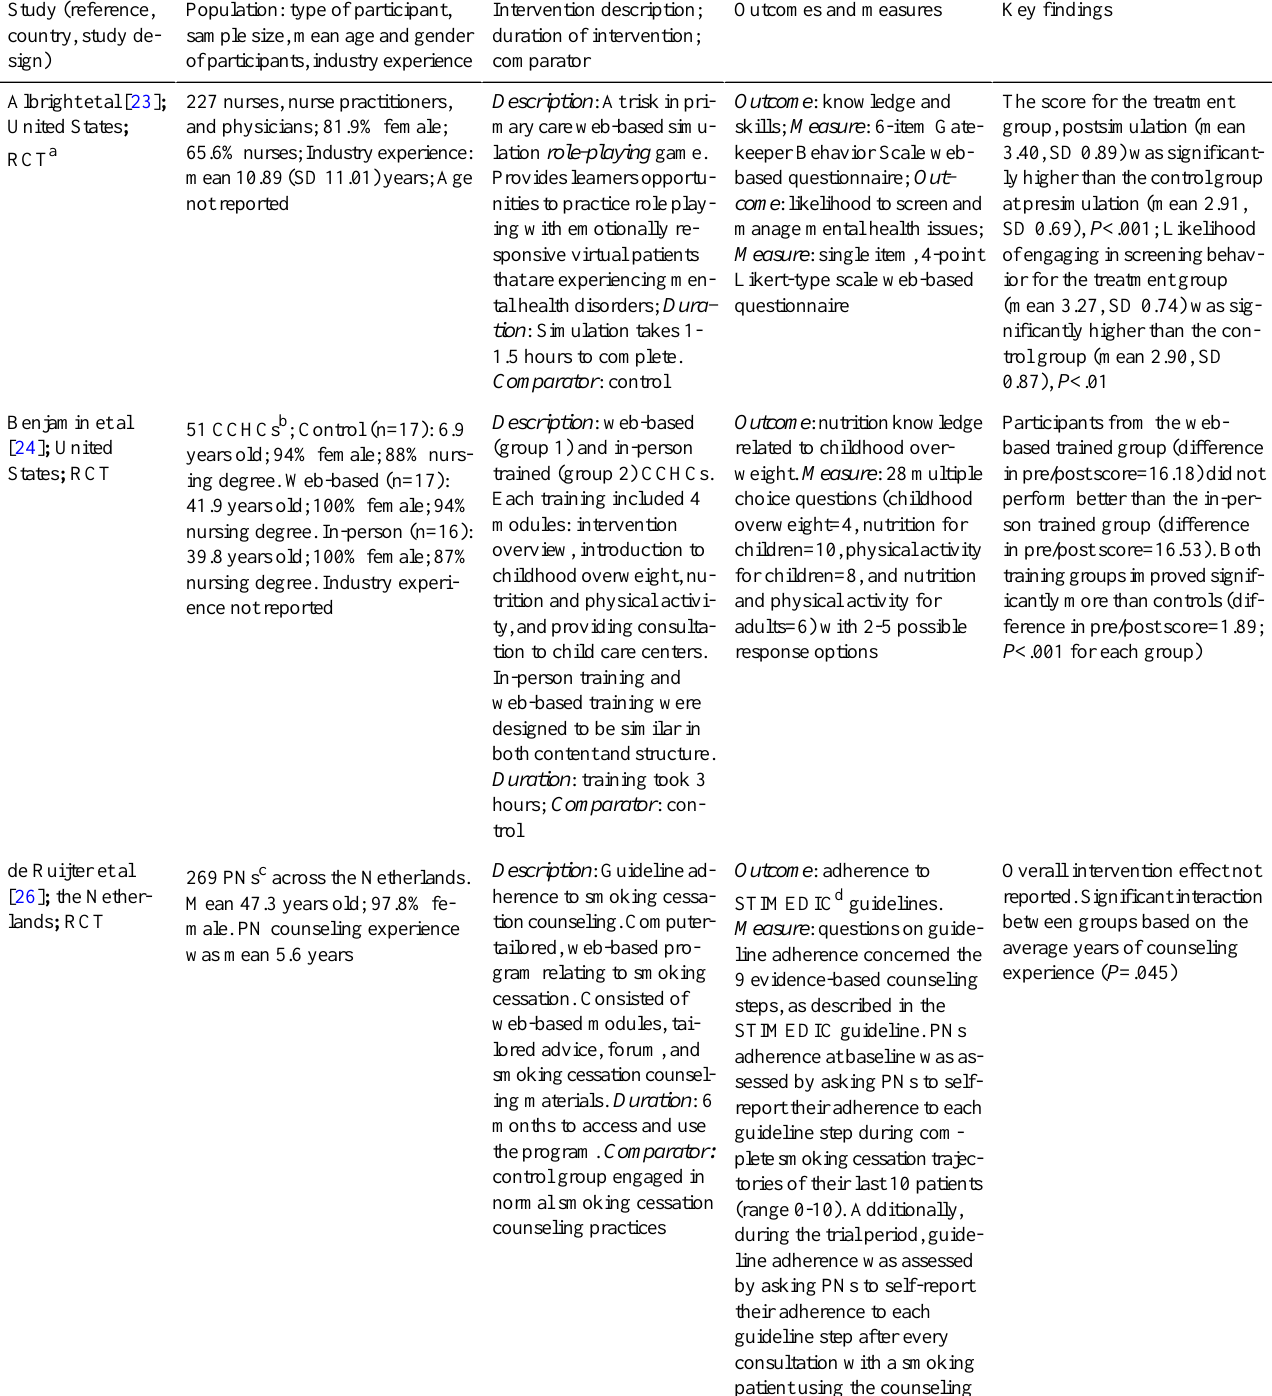
Table 1. Study characteristics and key findings.